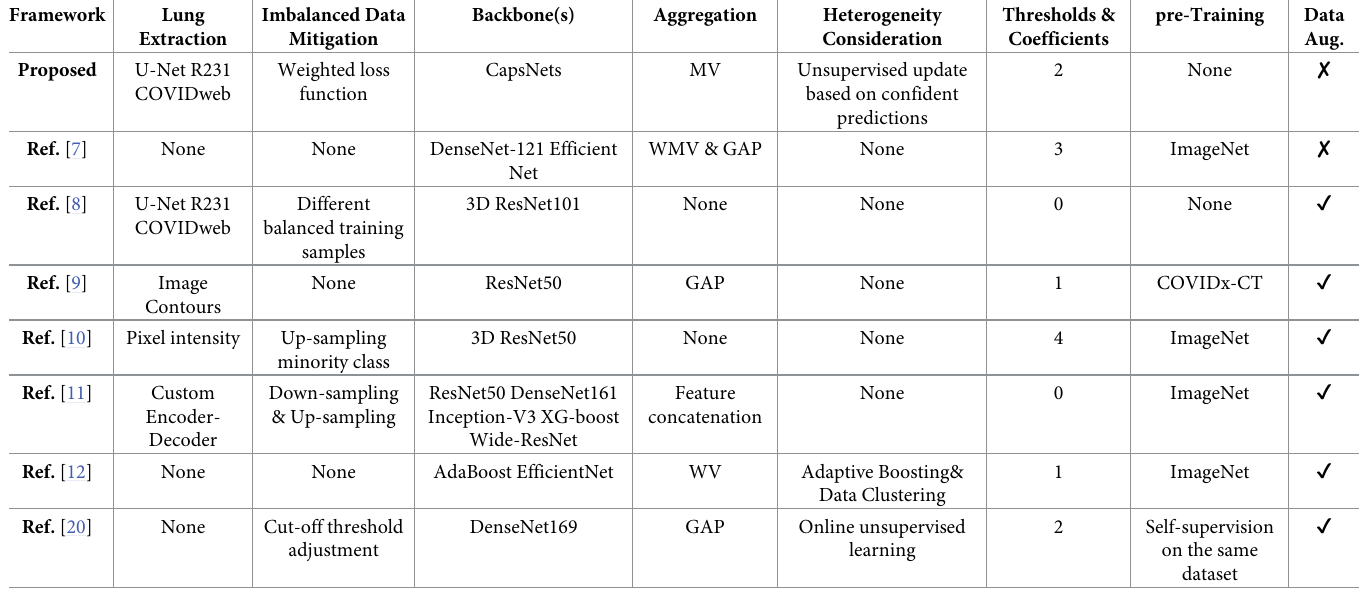
Table 3. Underlying key features of the proposed framework and seven models used for comparison in this study (i.e., top six models developed following the SPGC-COVID challenge, and one model developed outside of the scope of this challenge). Framework Lung